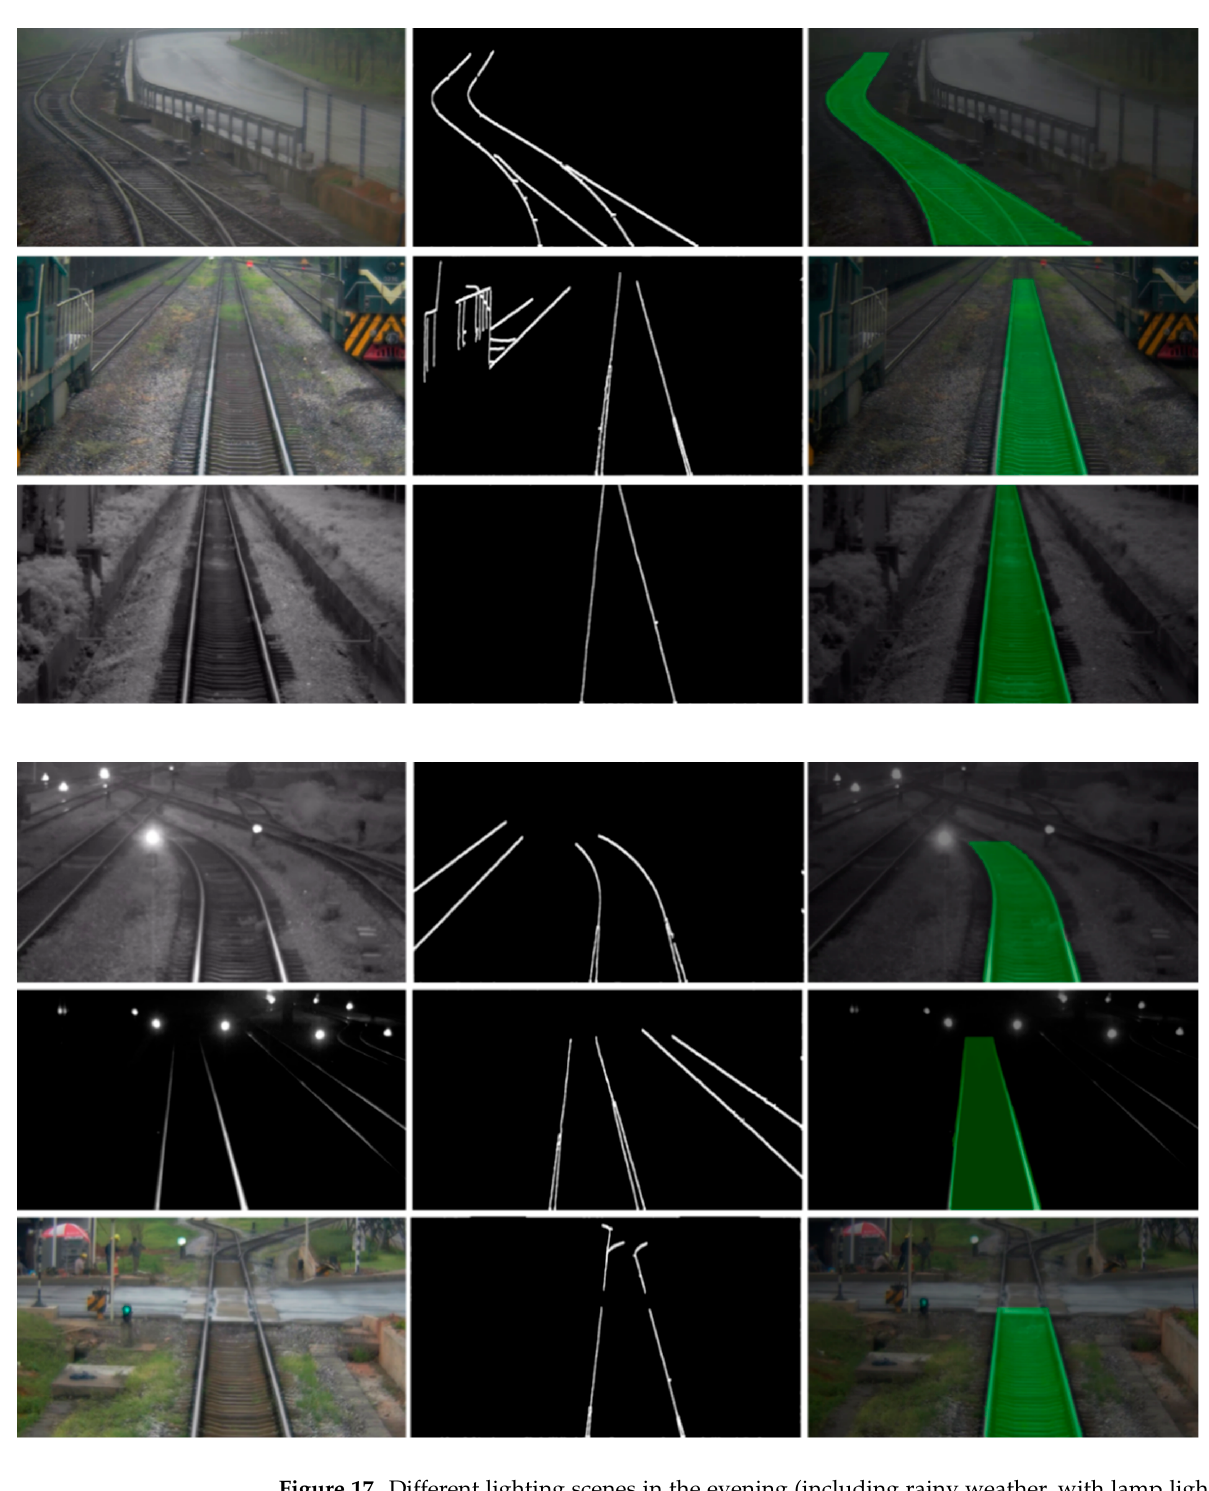
Figure 17. Different lighting scenes in the evening (including rainy weather, with lamp light and without lamp light).